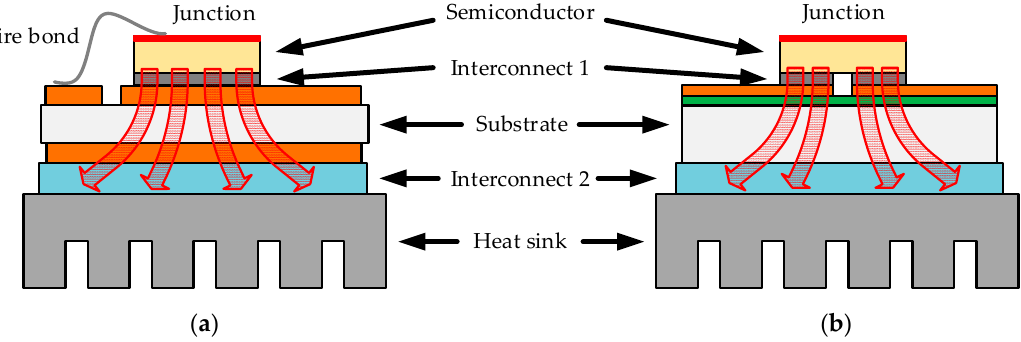
Figure 1. Typical thermomechanical set-up for power electronics ( a ) and solid-state lighting (SSL) ( b ) in a general manner with heat flow from junction to heat sink through semiconductor, interconnect 1 (single electrical contact in ( a ) and multi electrical contact in ( b )), substrate (direct bonded copper (DBC) in ( a ) and insulated metal substrate printed circuit board (IMS-PCB) in ( b )) and interconnect 2 with a spreading of the heat.